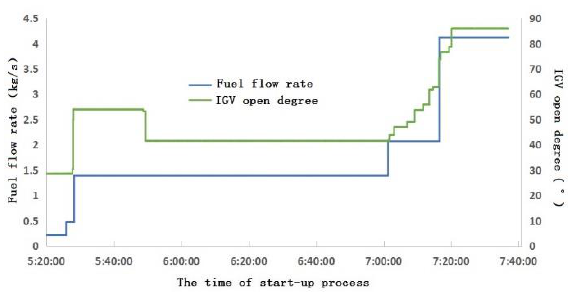
Figure 20. Open degree of burner nozzles during the start-up period.